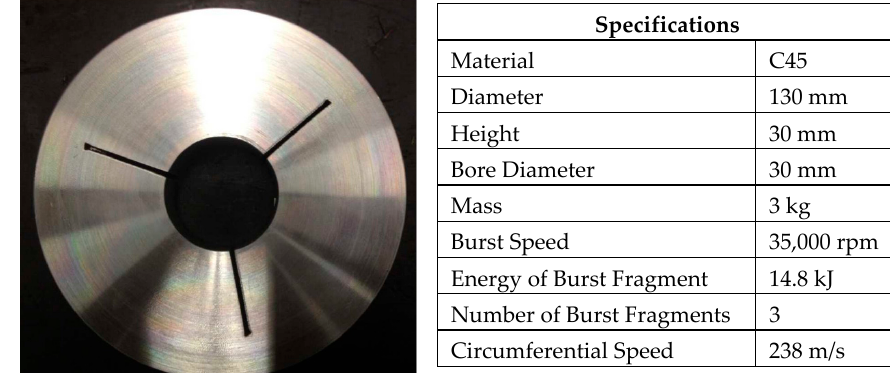
( b ) Figure 6. ( a ) Broken magnetic coupling in glass debris of containment shroud; ( b ) damaged bearing race. 2.